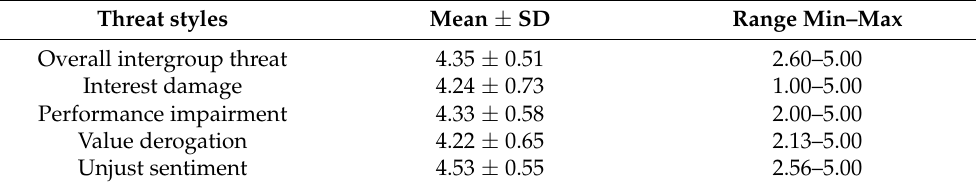
Table 4. Mean and standard deviation of intergroup threat ( n = 423).